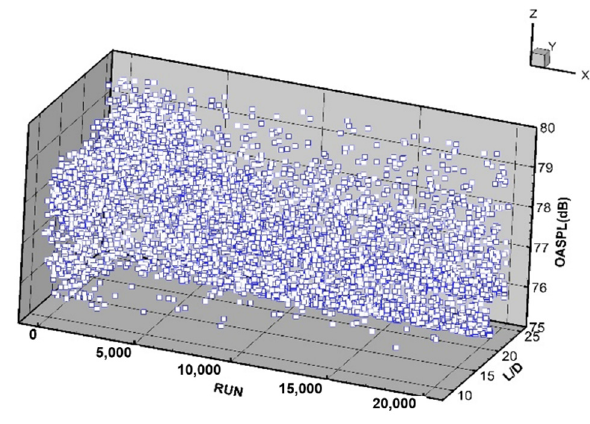
Figure 18. The variation of the constraints in the optimization process.